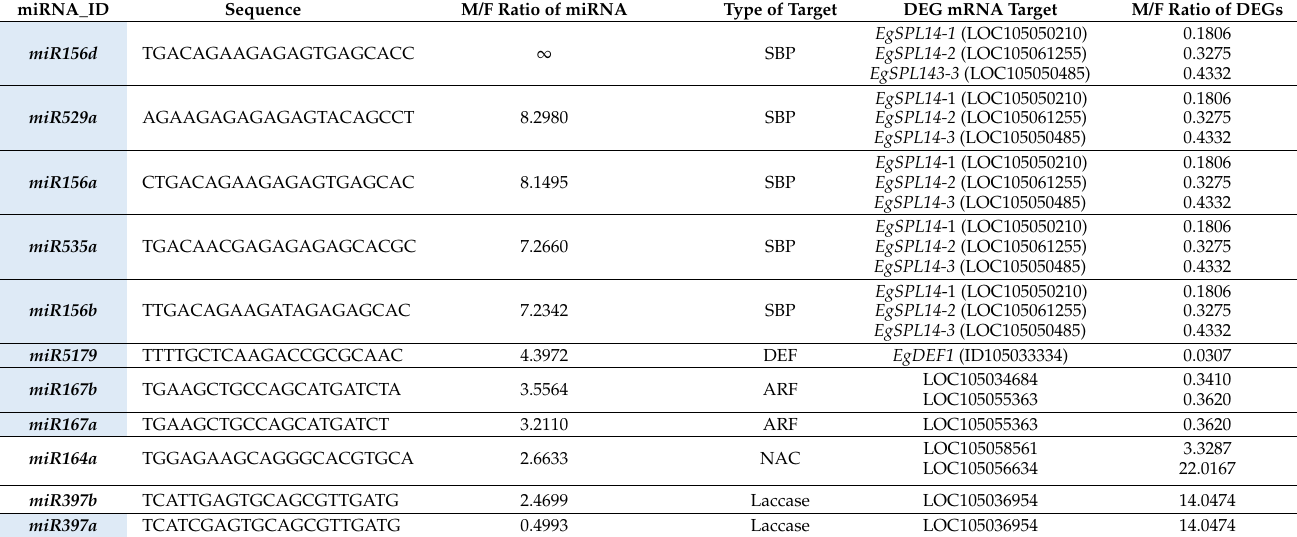
Table 1. Micro-RNAs with potential targets represented in the gene sets showing sex-dependent expression. Expression values were normalised using DESeq for DEGs and per million counts for miRNAs prior to the calculation of M/F ratios. Only miRNAs with an expression ratio above 2 or below 0.5 were considered. Pale blue highlighting in the left-hand column indicates miRNAs for which target mRNAs with a reverse accumulation profile were identified. The “ ∞ ” symbol indicates that miR156 was detected only in the male inflorescence, albeit in small